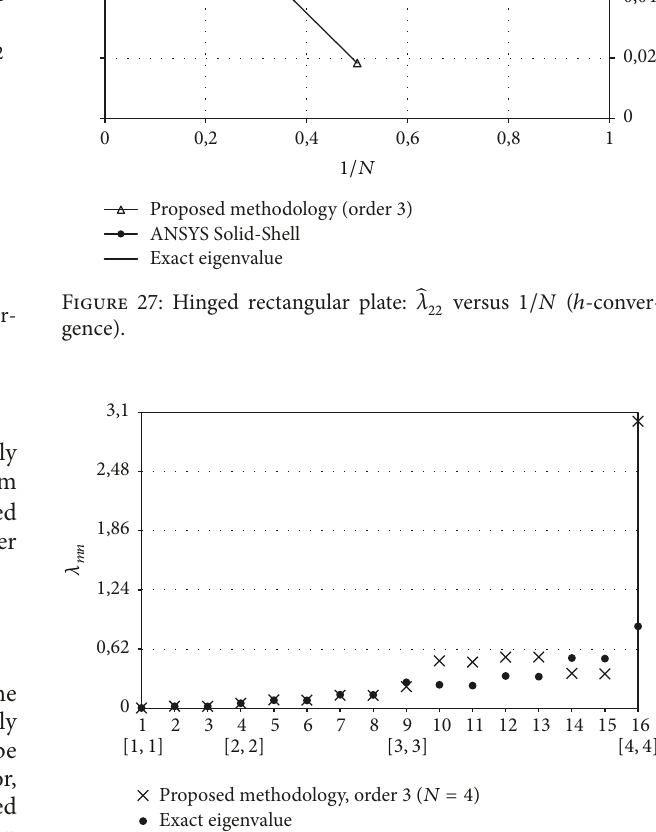
Figure 28: Eigenvalues (hinged rectangular plate; third-order brick, 𝑁 = 4